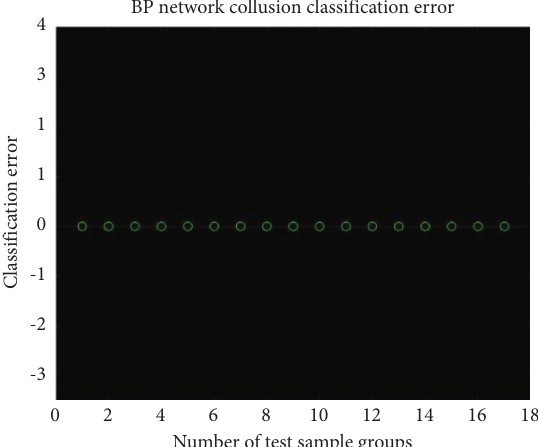
Figure 10: BP neural network classification error.